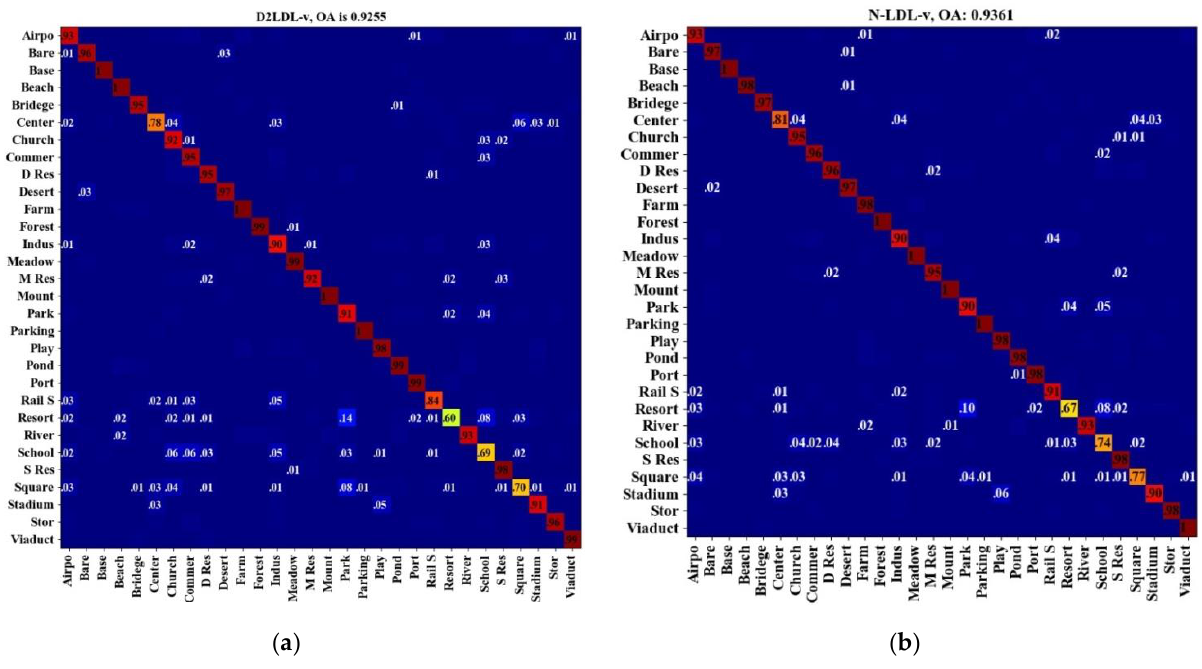
Figure 10. Confusion matrices on AID-0.1 that are obtained using ( a ) D2LDL-v and ( b ) N-LDL-v. Elements smaller than 0.01 are omitted.